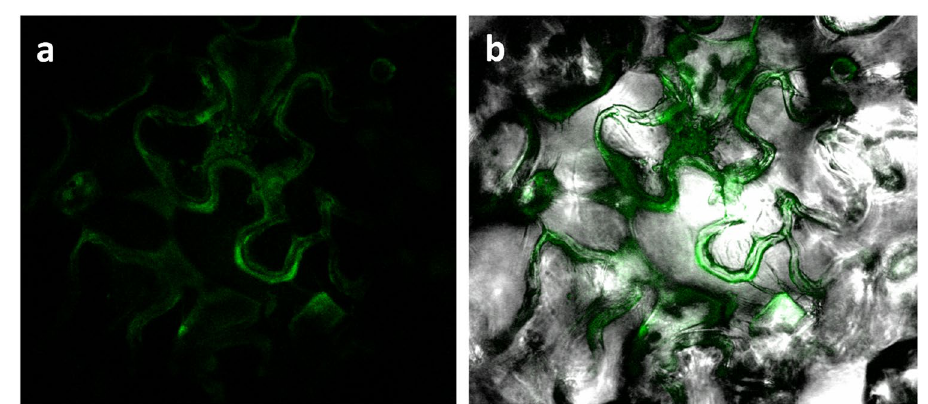
Figure 7. Subcellular localization of Hs-Tyr ::GFP within N. benthamiana leaf epidermal cell. ( a ) The green fluorescence originates from Hs-Tyr ::GFP fusion protein localized in the cytoplasm of the cells. ( b ) Merged image shows the GFP signal in bright